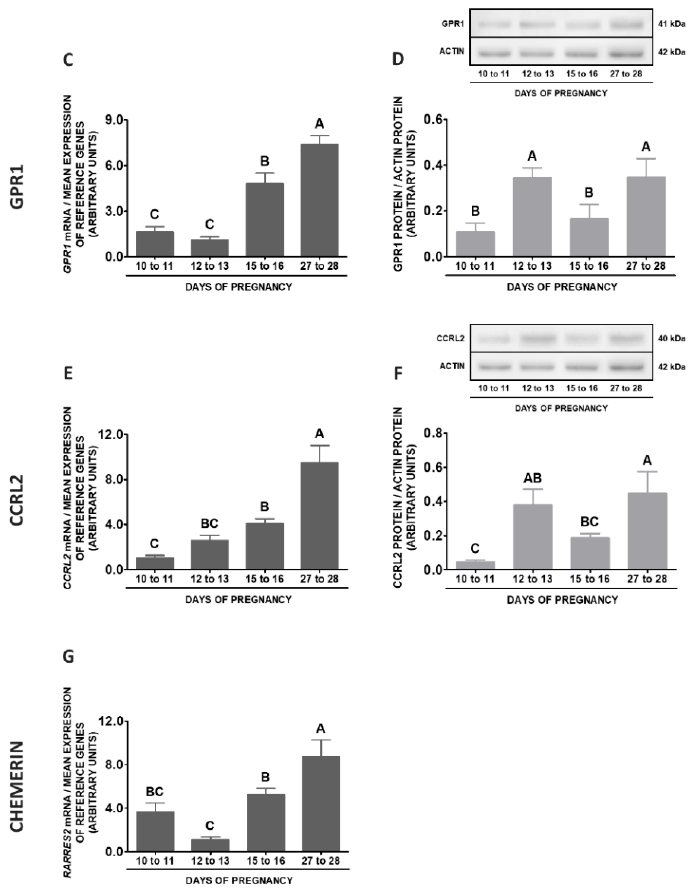
Figure 12. Chemerin system expression in the porcine stalk median eminence (SME) during early pregnancy. Gene and protein expression of chemokine-like receptor 1 (CMKLR1; A and B ), G protein-coupled receptor 1 (GPR1; C and D ) and C-C motif chemokine receptor-like 2 (CCRL2; E and F ), as well as chemerin ( RARRES2 ) mRNA content ( G ) in the porcine SME on days: 10 to 11, 12 to 13, 15 to 16 and 27 to 28 of pregnancy. Gene expression was determined by qPCR. Protein expression was determined by Western blotting; upper panels: representative immunoblots; lower panels: densitometric analysis of CMKLR1/GPR1/CCRL2 proteins relative to actin protein. Representative actin blots are identical for all chemerin receptors though proteins have been analysed on different gels. Results are presented as means ± SEM ( n = 5). Bars with different superscripts differ (one-way ANOVA at p < 0.05 followed by Tuckey post-hoc test at p <